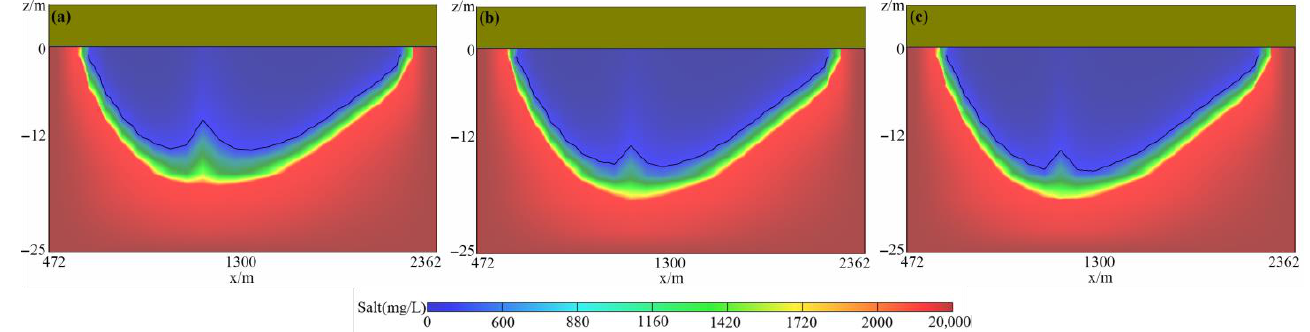
Figure 3. Sectional views of freshwater lenses in 10 years ( a ), 30 years ( b ) and 50 years ( c ).